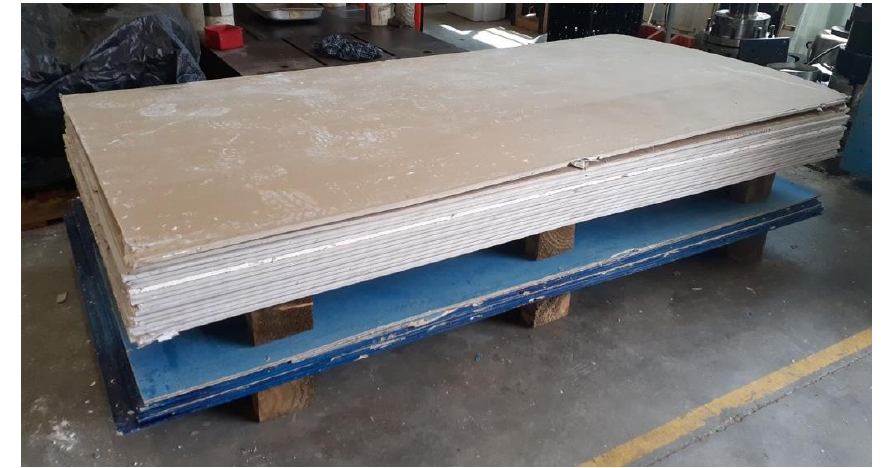
Figure 4. Infill panels: ( top ) gypsum plasterboards, ( bottom ) cement- or blue-boards. Materials 2020 , 13 , x FOR PEER REVIEW